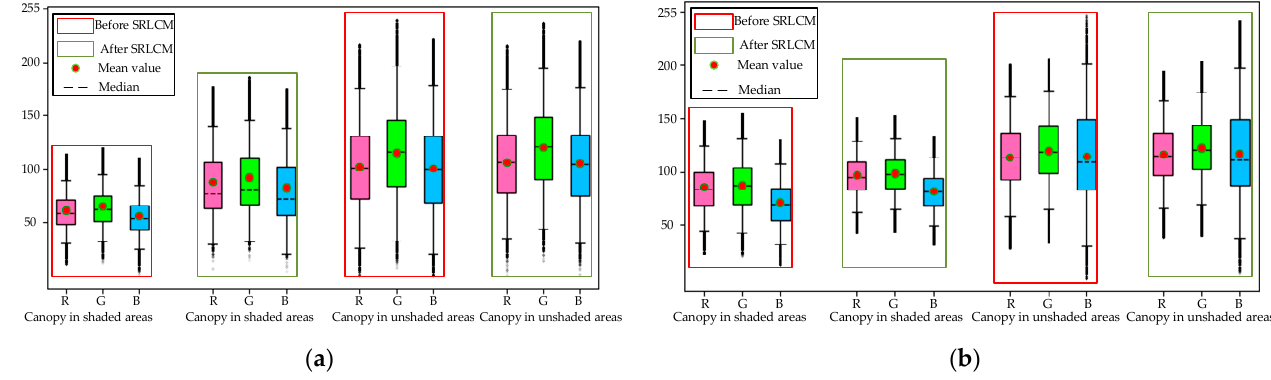
Figure 7. Gray mean of R, G, and B channels in the canopy regions before and after the shadow region luminance compensation method (SRLCM). ( a ) Images of fruit trees that were taken under sunny conditions with direct solar illumination, and ( b ) images of fruit trees that were taken under cloudy conditions without direct solar illumination.